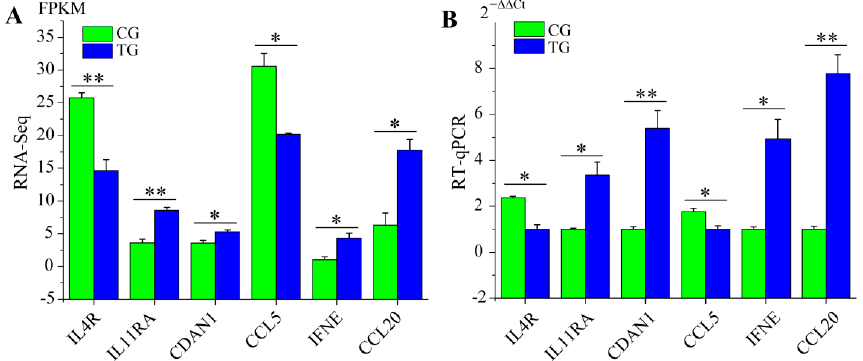
Figure 8. Verification of RT-qPCR for some differentially expressed genes. ( A ) RNA-Seq results. ( B ) RT-qPCR results. The results are shown as the mean ± SE of three replicates. (* p < 0.05; ** p < 0.01).